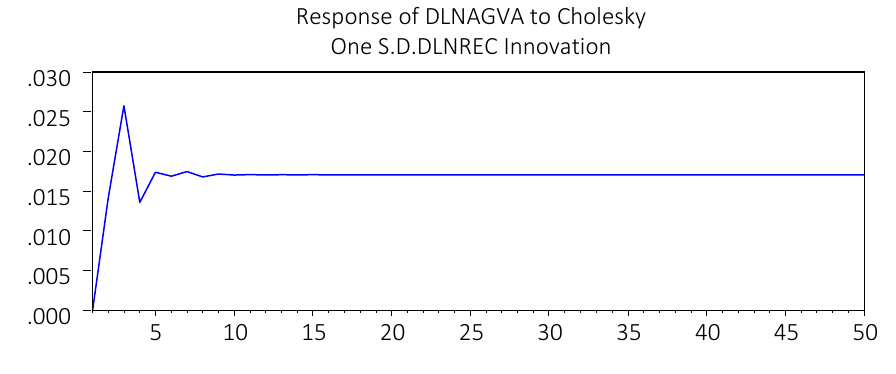
Figure 3b. REC policy response on agricultural development by 2063 (African Union